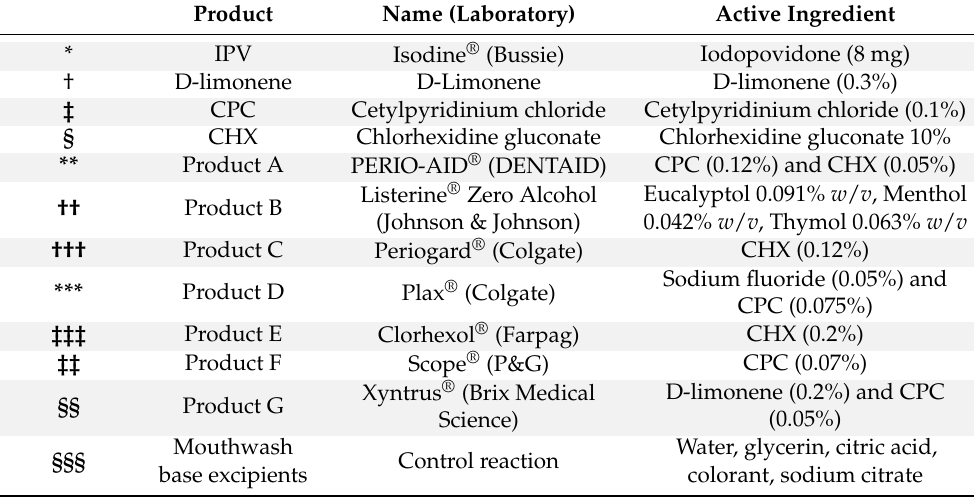
Table 1. As a control reaction, saline solution or excipient solution (water, glycerin, citric acid, colorant, sodium citrate) was used. Table 1. Solutions used in the